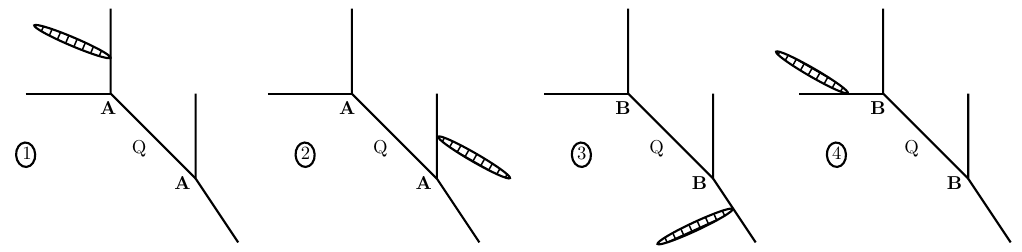
Figure 15: Branes attached to various legs of a diagram for the resolution of (cid:67) 3 / (cid:90)